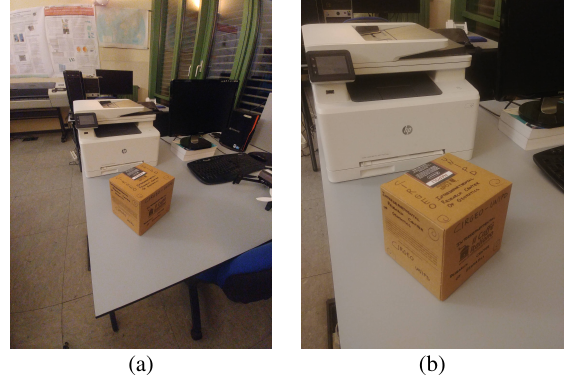
Figure 12. Images acquired with the LG G6 dual